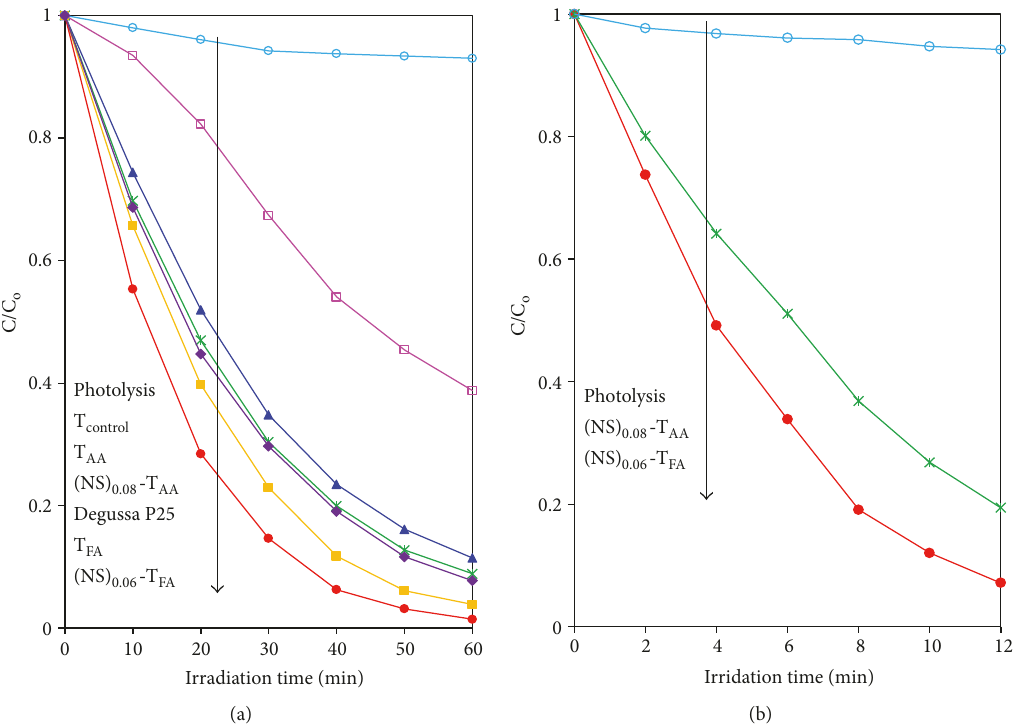
Figure 8: Photolytic and photocatalytic activity curves of 4-chlorophenol degradation under (a) UV irradiation and (b) visible irradiation for Degussa P25 and the selected photocatalyst powders calcined at 700 °